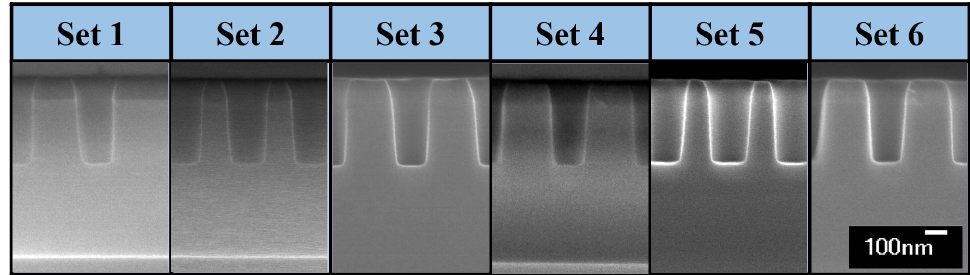
Figure 3. Cross-sectional SEM images of 250-nm contact holes each set point and in the 0.6 mm wafer.